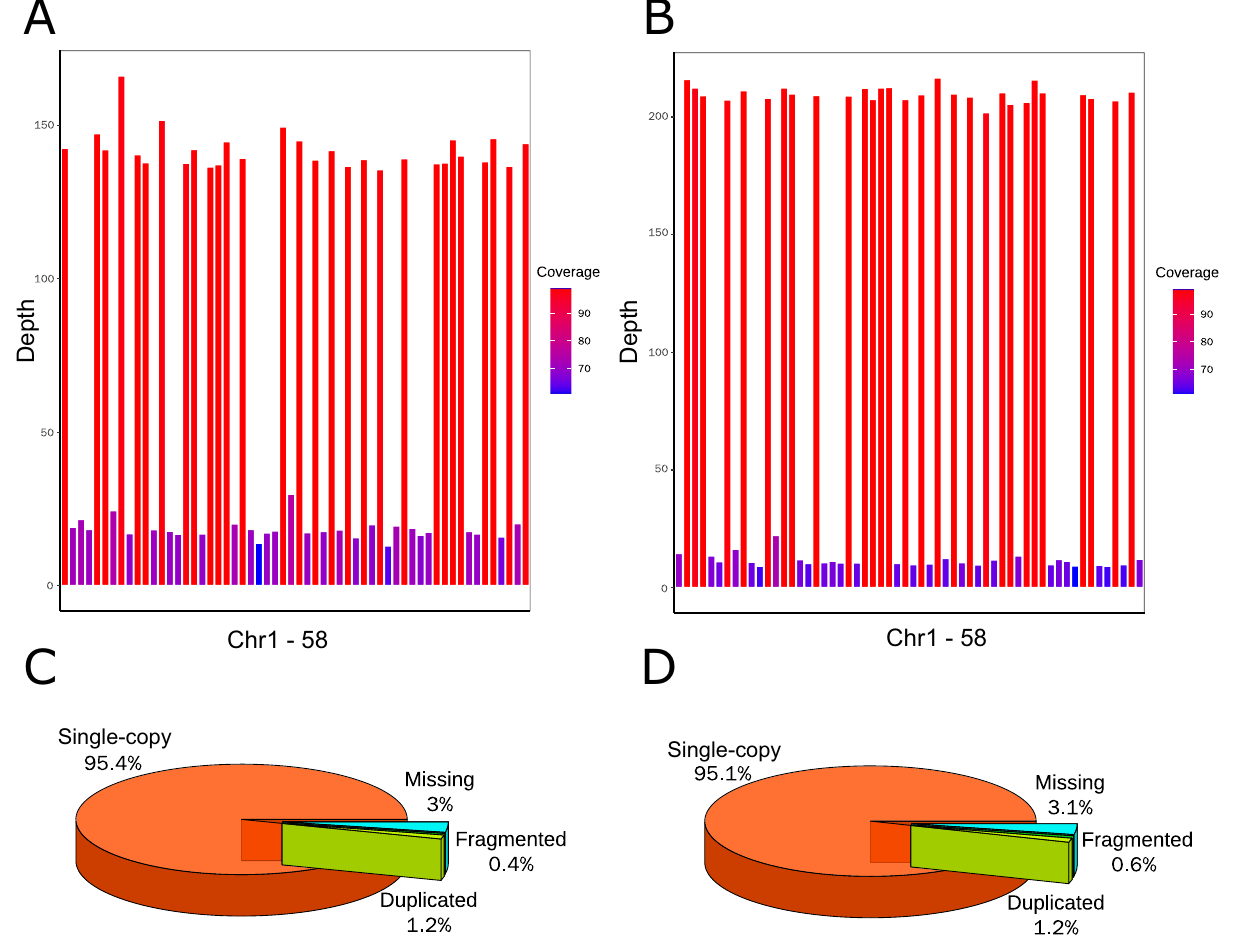
Figure 2. Assessments of the de novo assembly. ( A , B ) The coverages and meandepths of genomic short reads from non-hybrid parents mapped to the de novo assembly for S. asotus and S. meridionalis , respectively. ( C , D ) are the BUSCO assessment results for the S. asotus and S. meridionalis genomes divided from the hybrid genome,